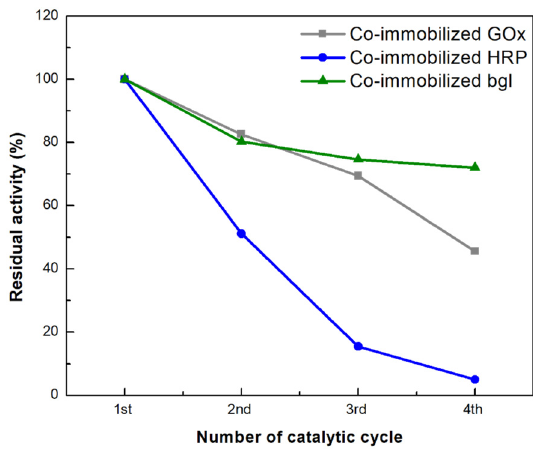
Figure 10. Residual activity of ( a ) free and co-immobilized GOx, ( b ) free and co-immobilized HRP, and ( c ) free and co-immobilized bgl after incubation at 60 °C.